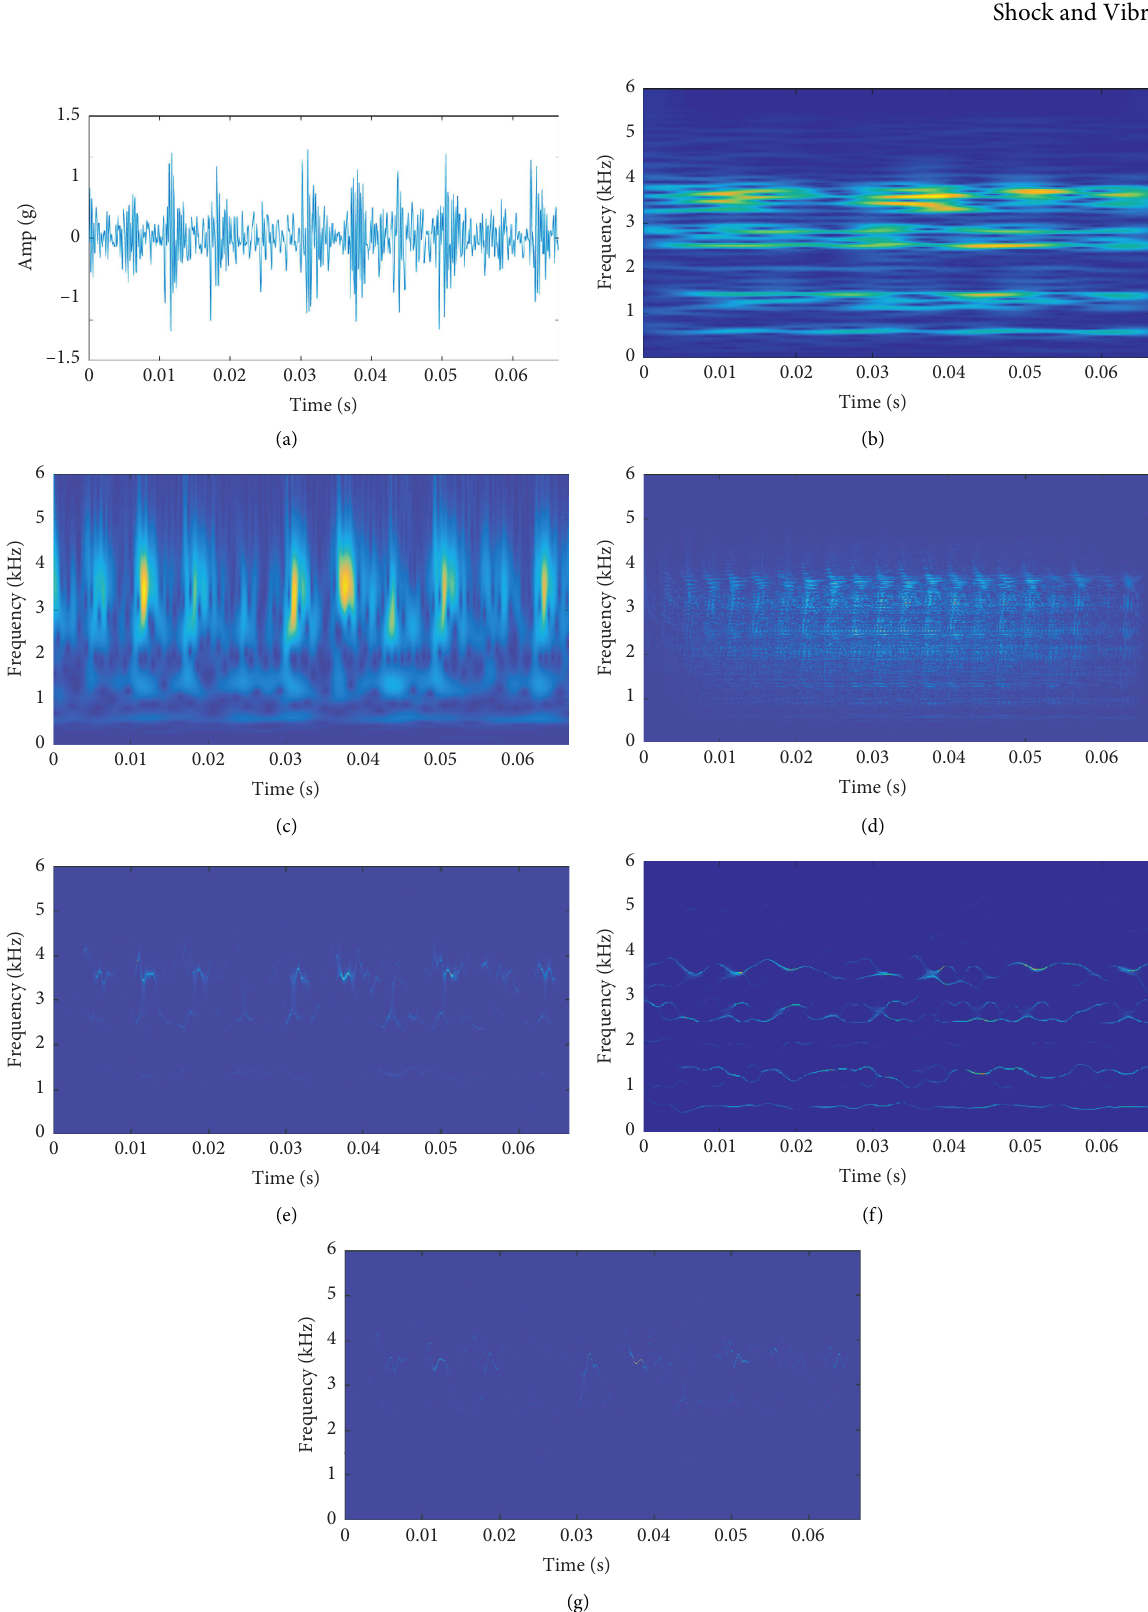
Figure 5: Time-frequency images of different frequency analysis methods: (a) raw signal; (b) STFT; (c) ST; (d) WVT; (e) SSST; (f) MSST; (g)